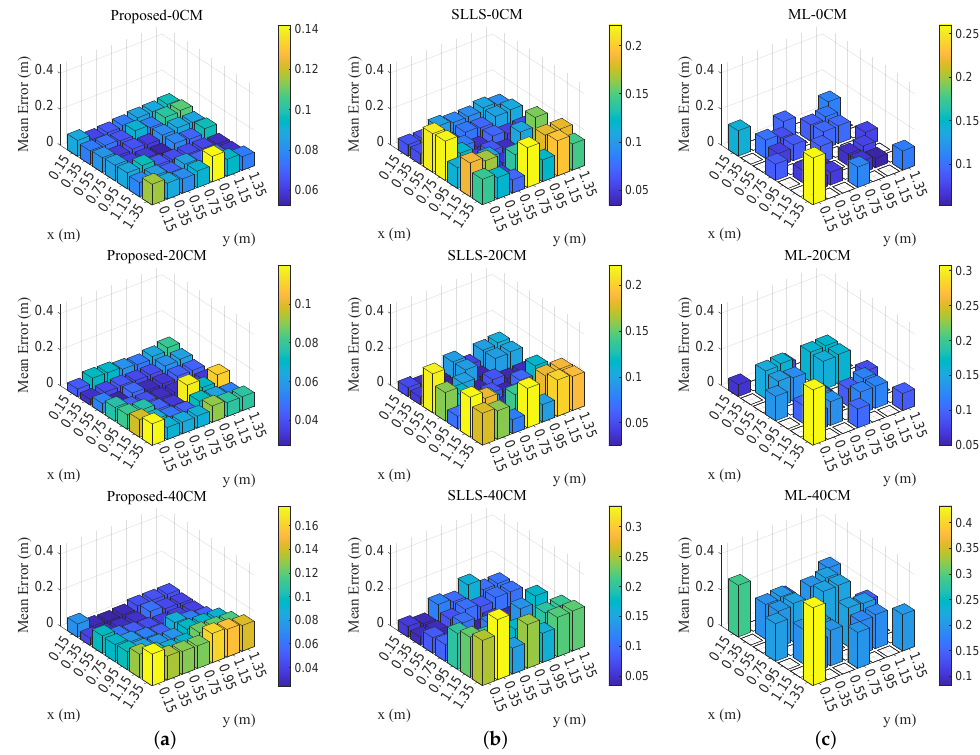
Figure 10. The 3D positioning distribution at different heights: ( a ) the proposed method, ( b ) the SLLS-based method, ( c ) the ML-based method.